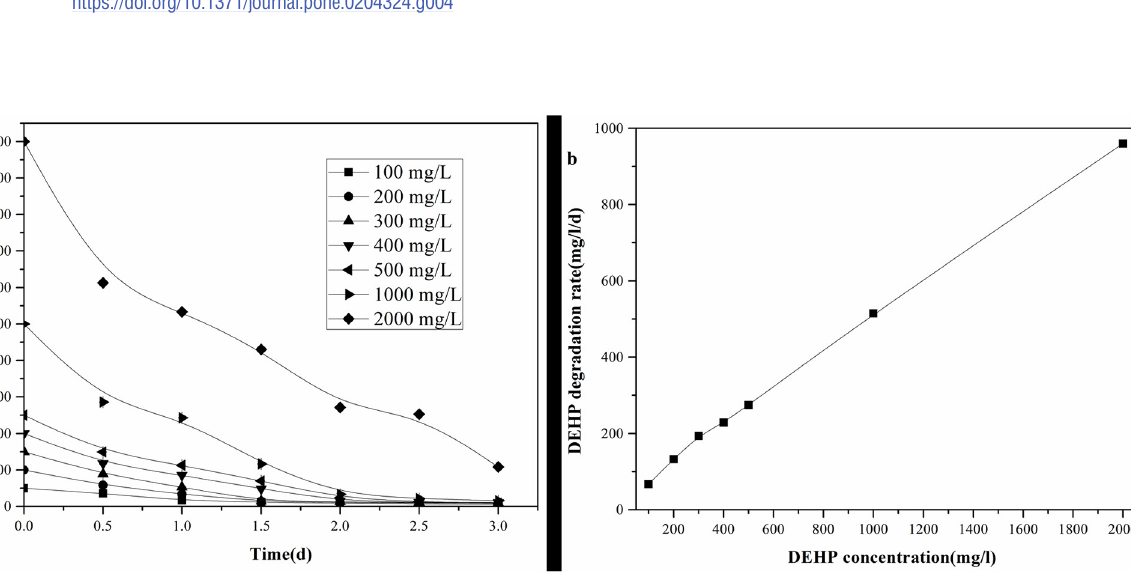
PLOS ONE | https://doi.org/10.1371/journal.pone.0204324 October 15,